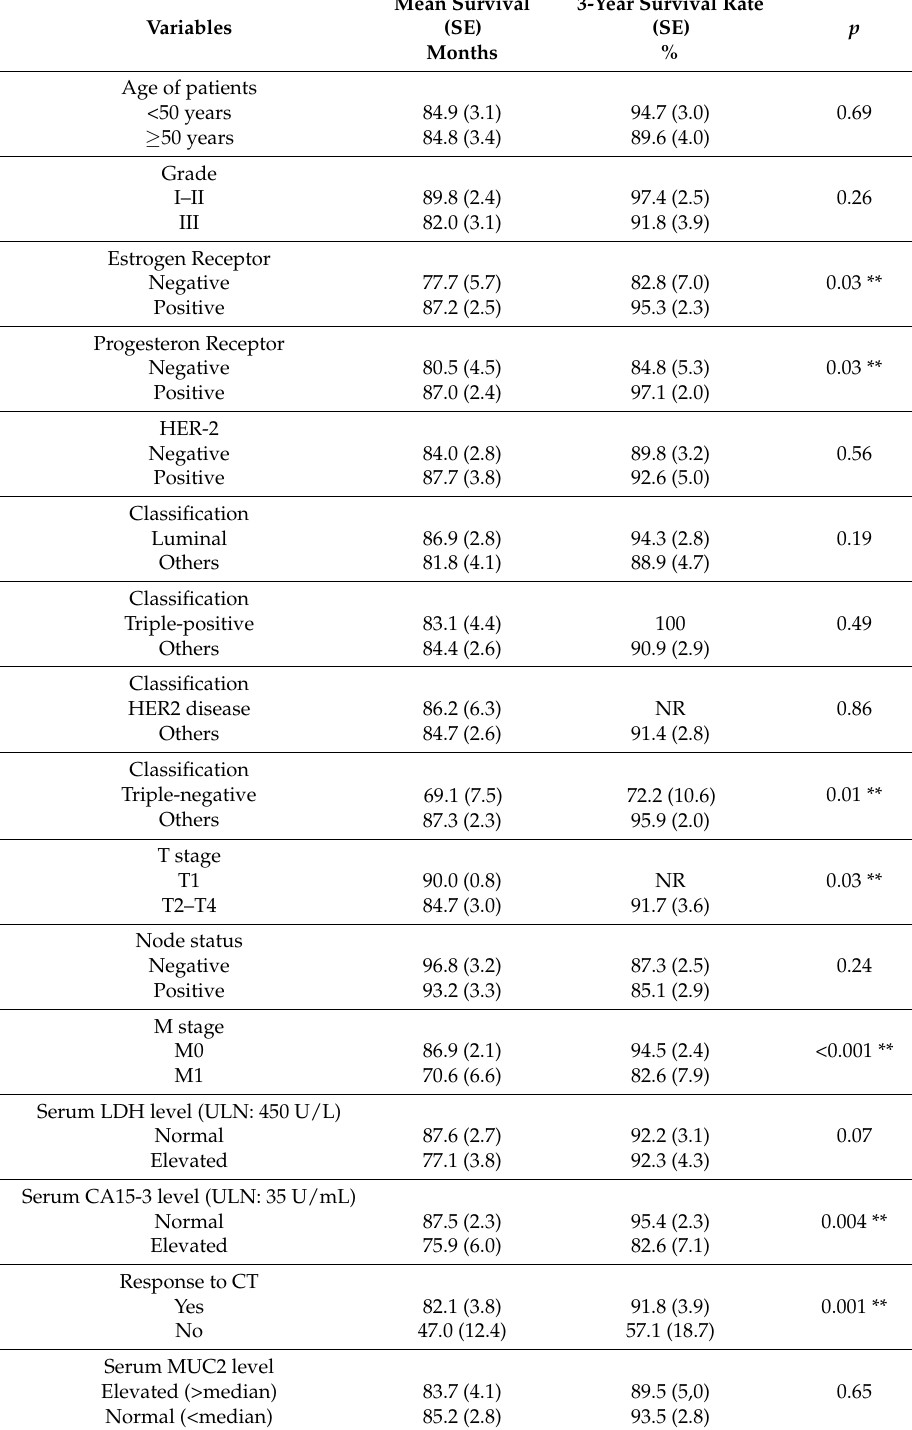
Table 4. Univariate analyses of